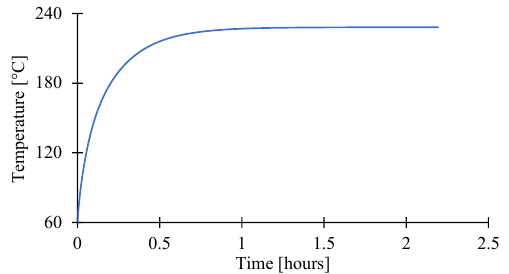
Figure 13. The temperature variation in the hotspot during winding under peak operating